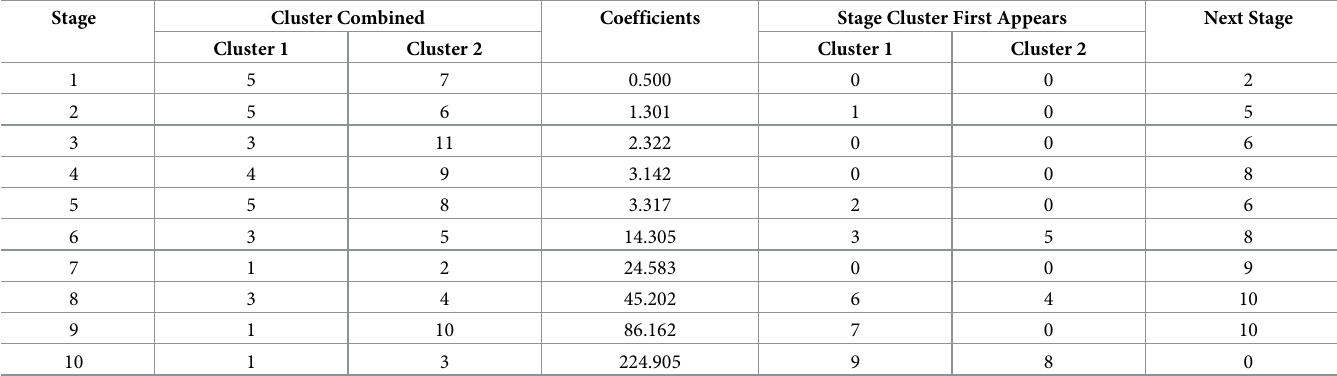
Table 1. Hierarchical clustering results.